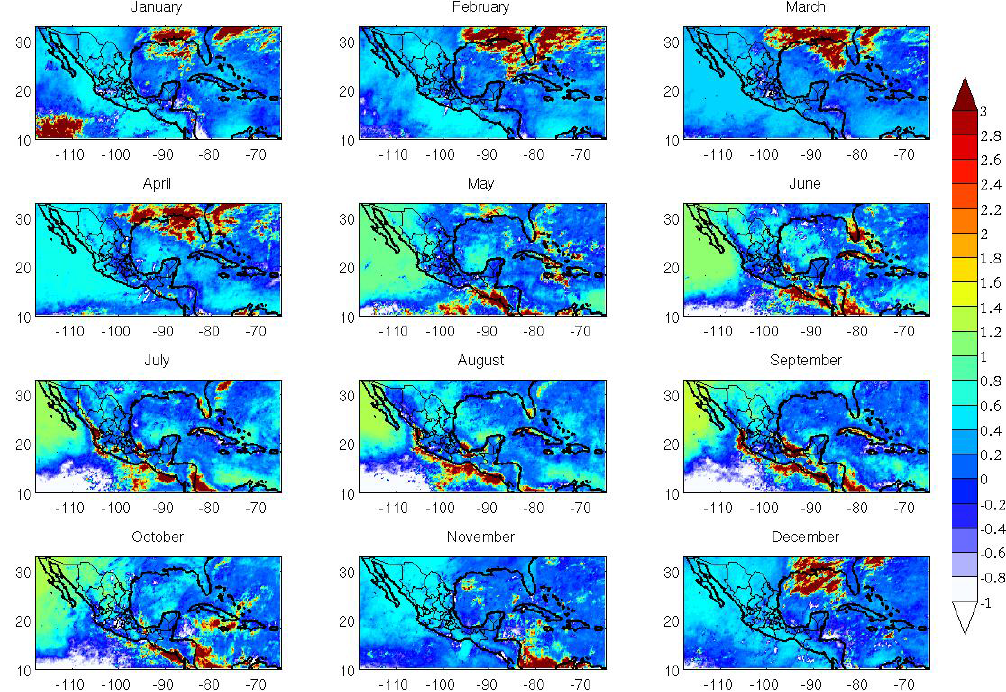
Fig. 4. Annual distribution of the spatial correlation coefficient between rainfall and lightning. The correlation coefficient is defined in the Eq.